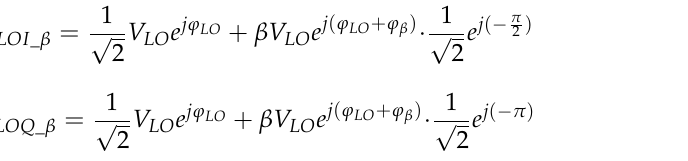
Figure 6. ( a ) Analysis of the influence of coupling 𝛽 on the imbalance; ( b ) Amplitude and phase imbalance caused by the coupling 𝛽 .